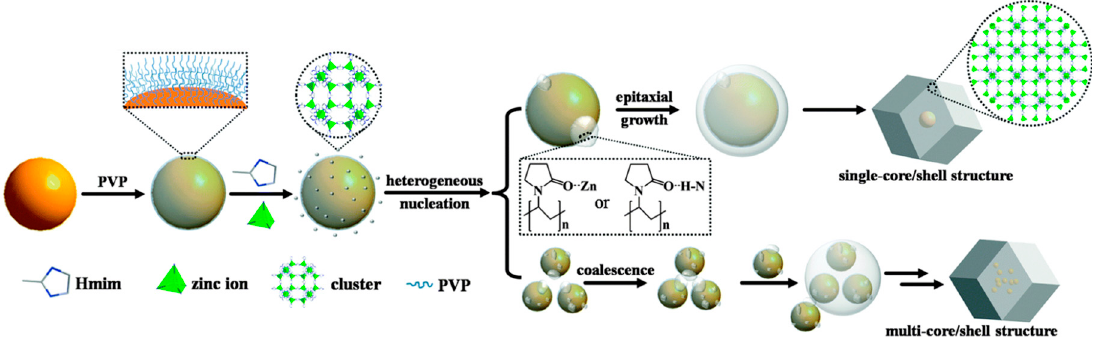
Figure 11. Encapsulation of Au-NPs into ZIF-8. Adapted with permission from Reference [74] from The Royal Society of Chemistry.